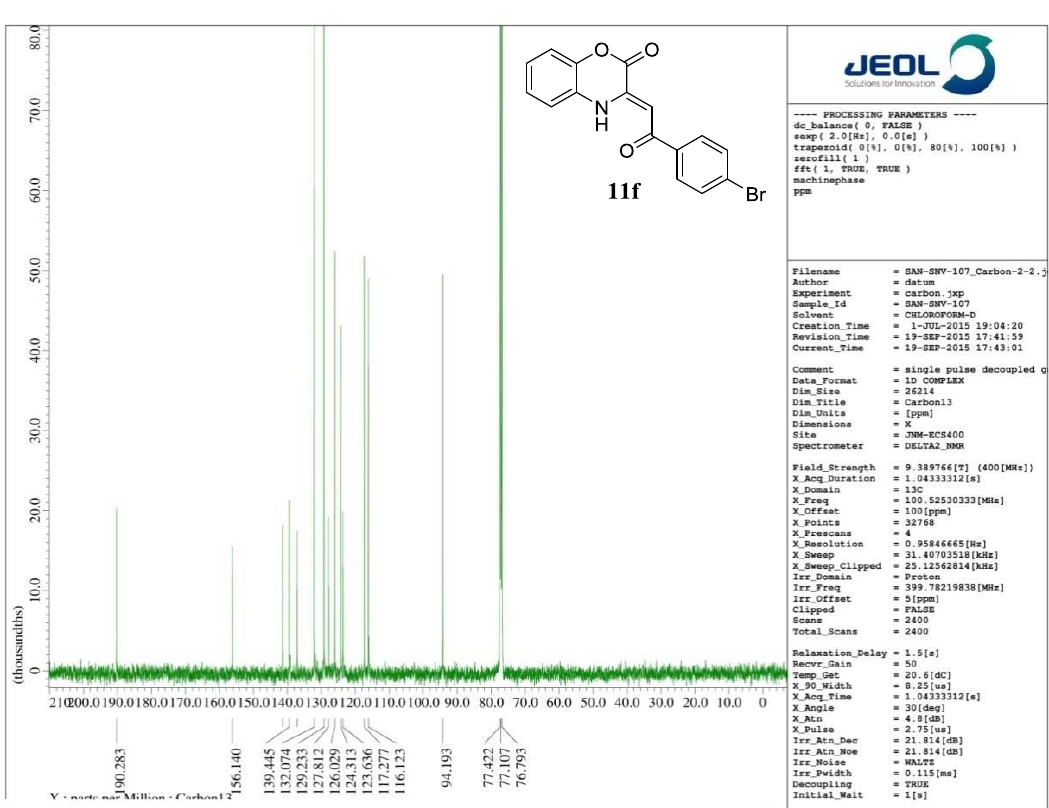
Figure 12. 13 C NMR Spectra of Compound 11f